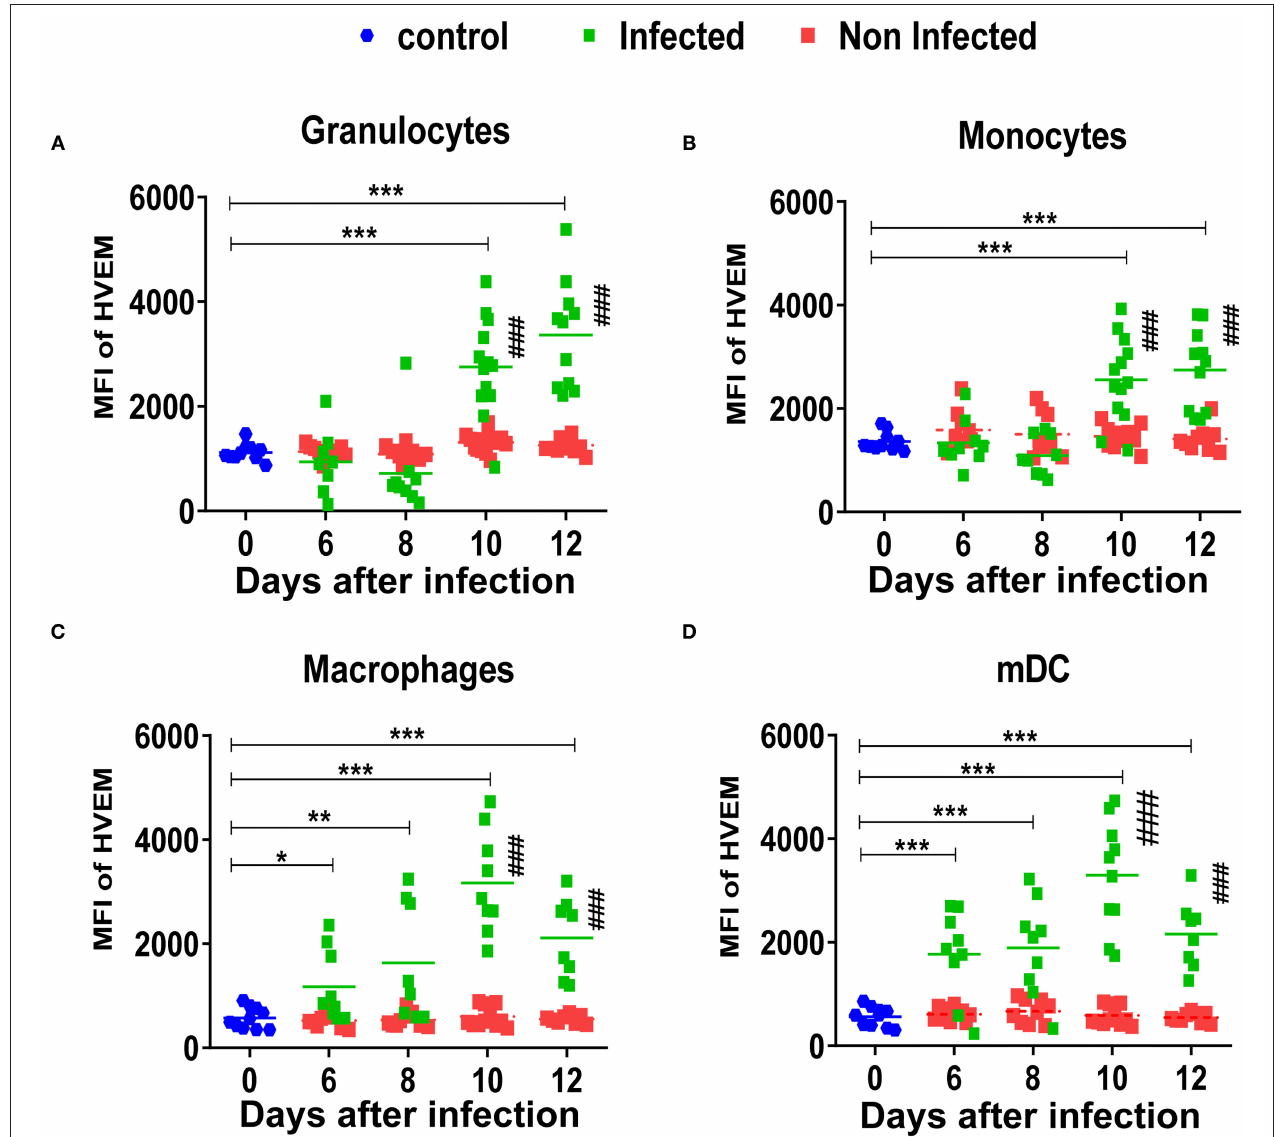
FIGURE 4 | Expression of HVEM on myeloid subpopulations after FV infection. C57BL/6 mice were infected with FV-mWasabi and splenocytes were isolated at different time points after infection. Multi-parameter flow cytometry analysis was used to compare the mean fluorescence intensity (MFI) of HVEM on the surface of infected (mWasabi + ; green), non-infected (mWasabi − ; red) and naive (day 0; blue) granulocytes (CD11b + Ly6C low Ly6G high ) (A) , monocytes (CD11b + Ly6C high Ly6G low ) (B) , macrophages (CD11b + Ly6G − Ly6C − F4/80 + CD11c low ) (C) , and mDC (CD11b + Ly6C − Ly6G − CD11c + ) (D) . Each dot represents an individual mouse, the mean MFI of HVEM are indicated. Data were pooled from three independent experiments with similar results. Differences between 0 and 6, 8, 10, and 12 days were analyzed using one-way ANOVA with a Tukey post-test (* p < 0.05, ** p < 0.005, *** p < 0.0005,). Differences between infected and non-infected cells were analyzed using unpaired t -test and are indicated in the figure (# p < 0.05, ## p < 0.005, ### p < 0.0005).